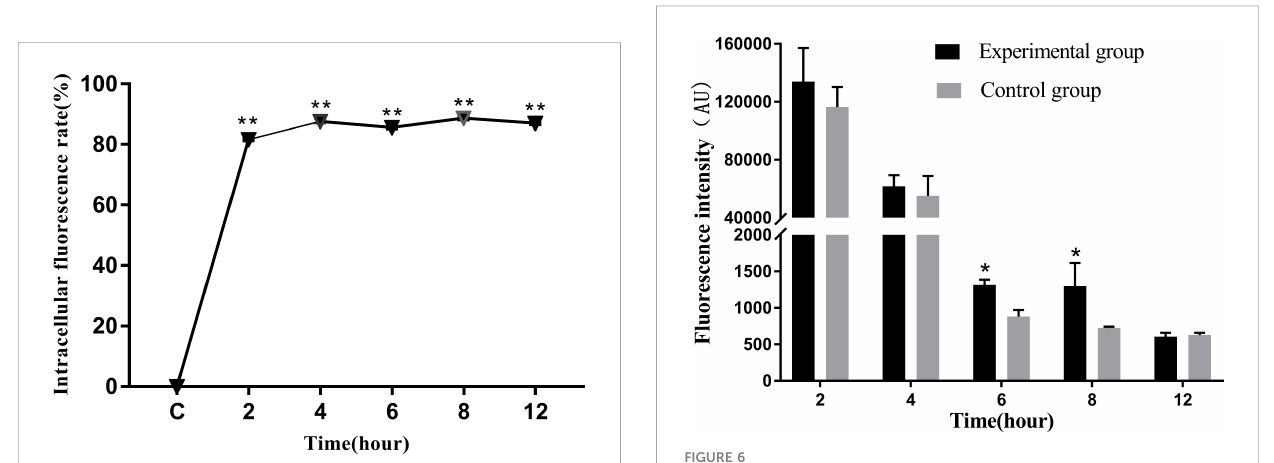
FIGURE 5 Intracellular fl uorescence rate of RAW264.7 infected with N. seriolae. Data are presented as mean ± SD of three independent experiments. ** P < 0.01 as compared with the control group.